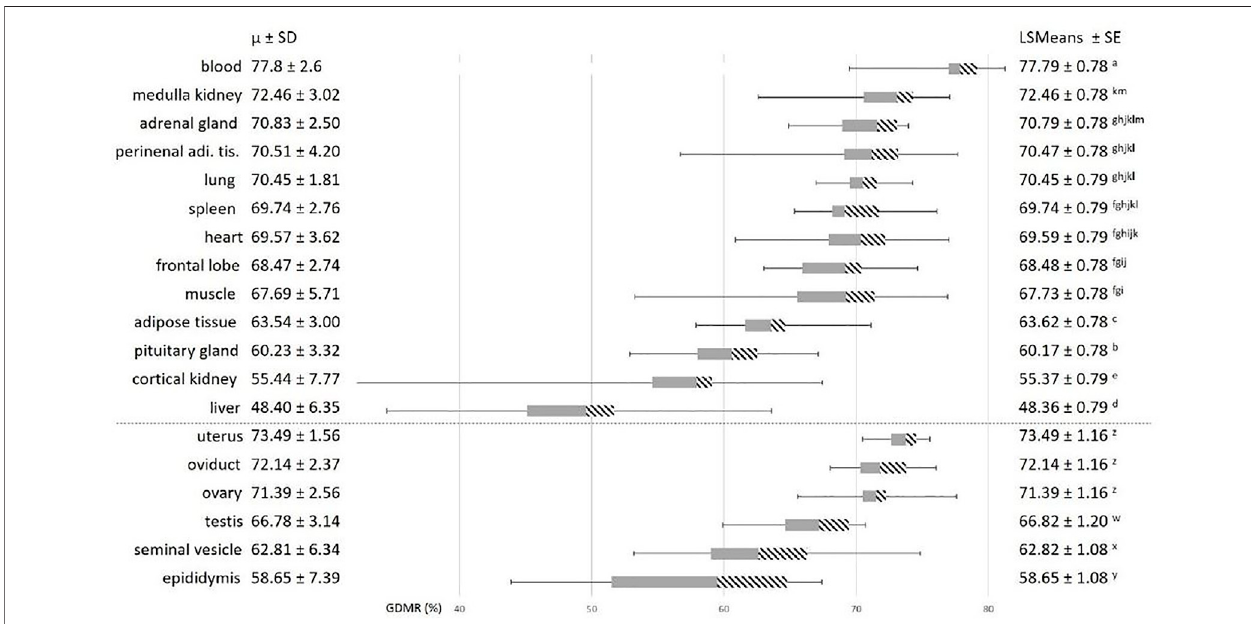
FIGURE2| VariabilityinglobalDNAmethylationrateinsomaticandreproductivetissues.AverageGDMRwascalculatedfor30animals,16malesand14females, (15 Blackbelly and 15 Romane sheep). The grey bars represent the second quartile, the dashed bars represent the third quartile, and the horizontal lines on each side correspondtothe fi rst(ontheleft)andthefourth(ontheright)quartiles.Thetissuesbelowthedottedlinebelongtofemaleandmalereproductivetracts.Statisticalmodel 3wasusedfortheanalysisofsomatictissues.Foreacheffect,valueswithdifferentsuperscripts(atom)werefoundtobesigni fi cantlydifferent( p < 0.05).Statistical model 4 was used for the analysis of reproductive tissues. For each effect, values with different superscripts (y to z) were found to differ signi fi cantly ( p < 0.05). perirenal adi. tis.: perirenal adipose tissue.